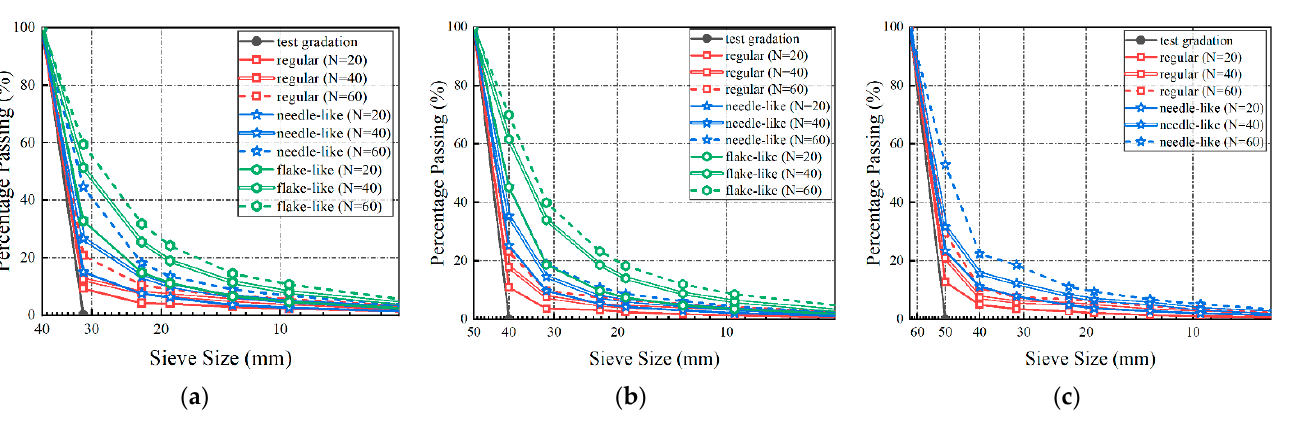
Figure 8. Evolution of particle size distributions with the prescribed number of impact-load applications (N) for distinctly shaped single-size ballasts: ( a ) 31.5–40 mm; ( b ) 40–50 mm; ( c ) 50–63 mm.